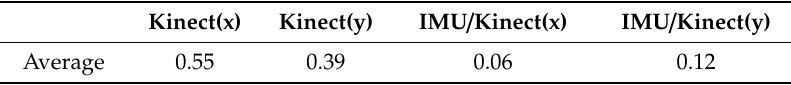
Table 8. Absolute values of the coordinate errors (in meters).